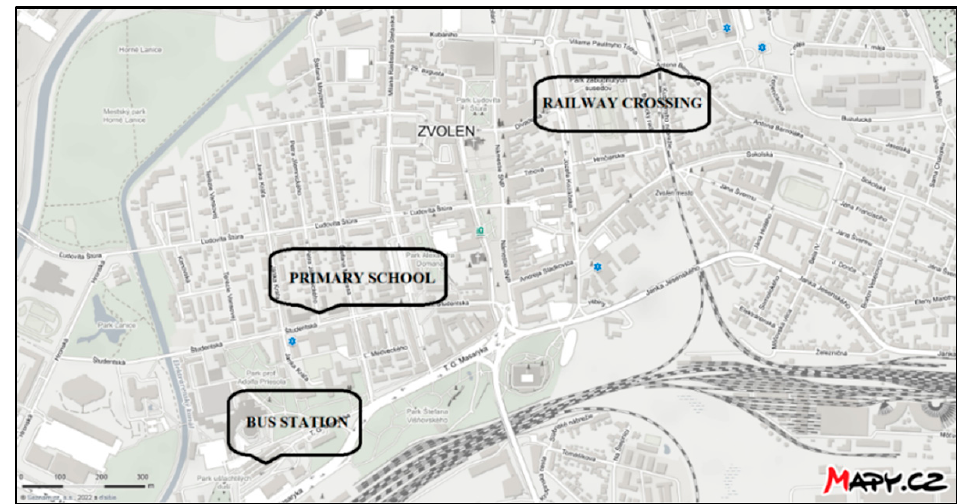
Figure 1. Distribution of measuring points in the city (based on mapy.cz).